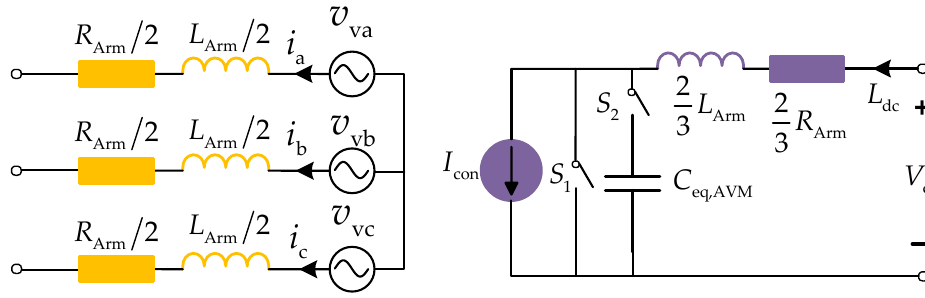
Figure 4. The average value model (AVM) topology.